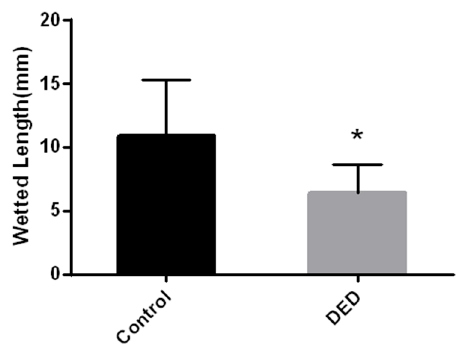
Figure 2. Wetted lengths, as determined by Schirmer’s tear tests, in the two groups. Basal tear secretion levels were significantly decreased in DED eyes compared with those in control eyes. * p < 0.05.